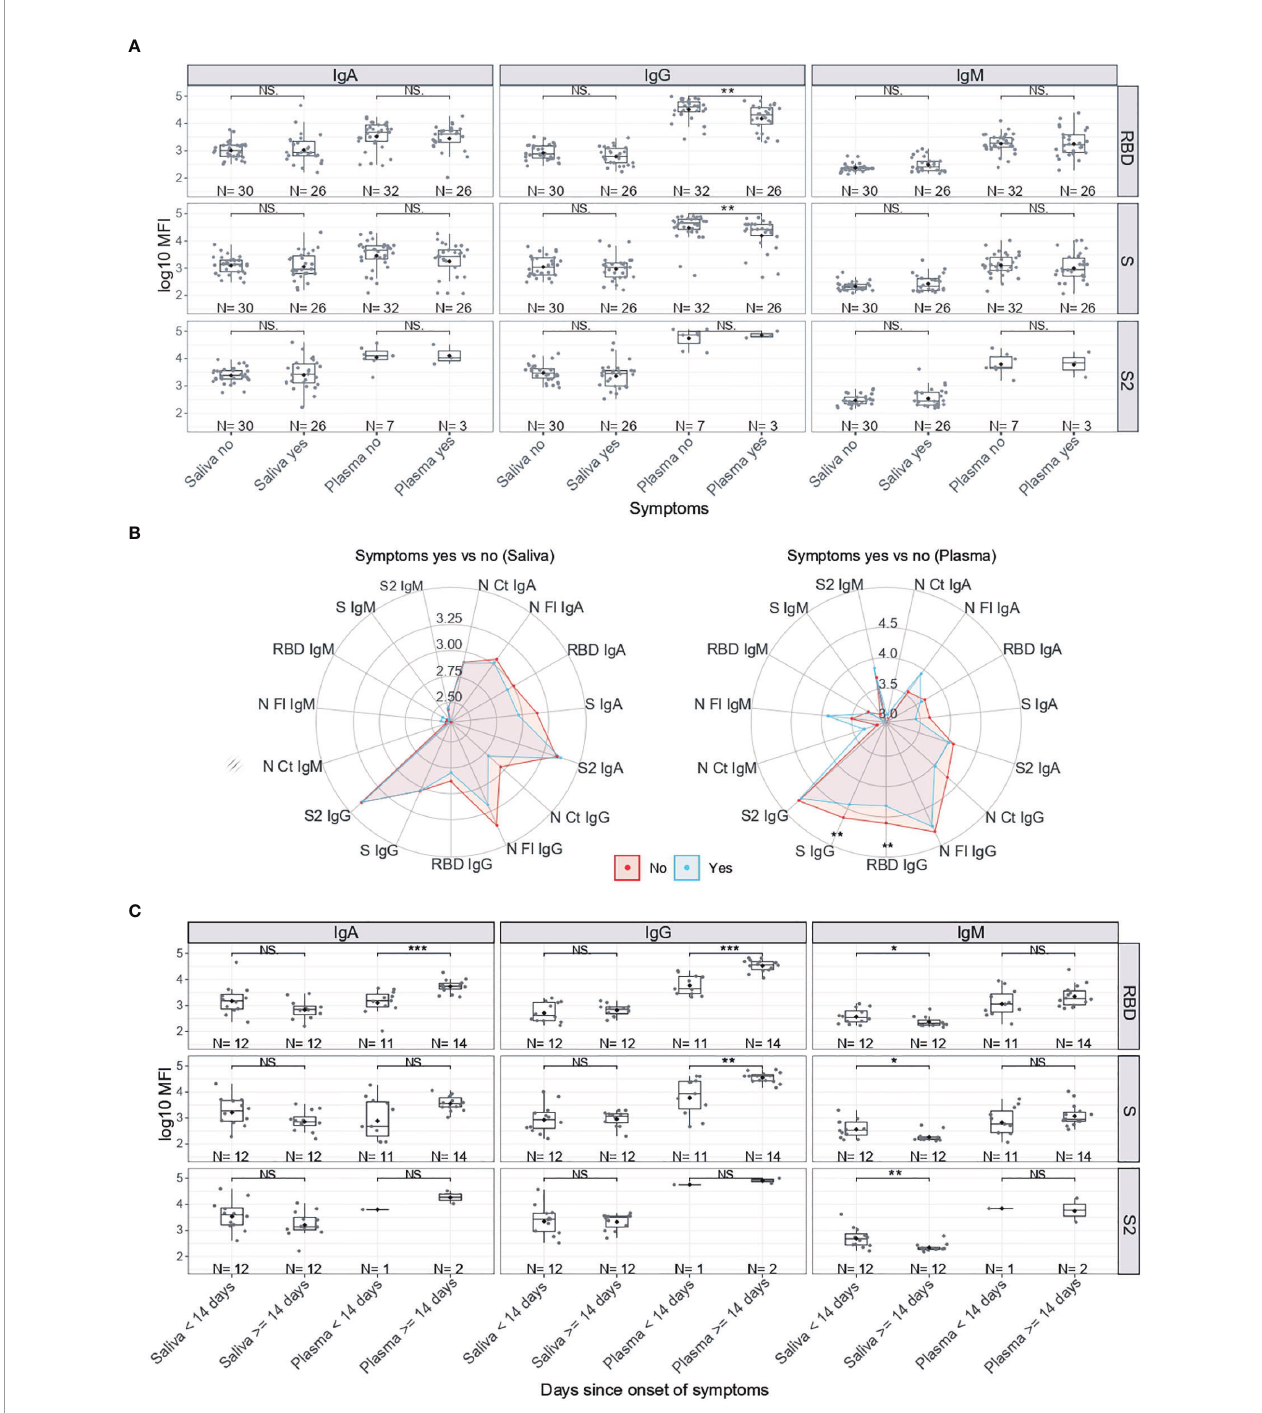
FIGURE 3 | Antibody levels by symptoms in SARS-CoV-2 positive individuals. (A) Boxplots showing log 10 MFI antibody levels in saliva samples tested heat inactivated and at 1/10 dilution, and serum (from plasma samples or dry blood spots) at 1/500. (B) Radar charts comparing the medians of antibody levels (in log 10 MFI) in serum/plasma and saliva between symptomatic (blue) and asymptomatic (red) individuals. (C) Boxplots showing log 10 MFI antibody levels in saliva and plasma samples by Time since onset of symptoms. Median log 10 MFI antibody levels were compared by Mann-Whitney U test. Statistically signi fi cant raw p-values are indicated with asterisks. ***p < 0.001, **p < 0.01, *p < 0.05, NS: not signi fi